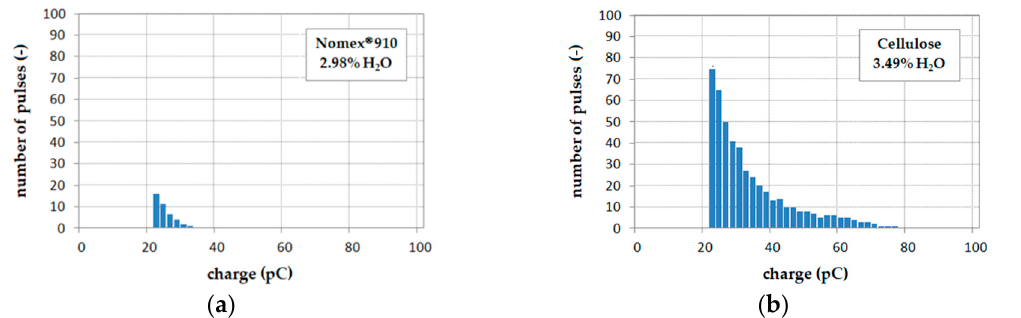
Figure 7. Frequency-amplitude distribution of partial discharges in aramid-enhanced cellulose paper ( a ) and cellulose paper ( b ), conditioned in the same conditions (medium moisture in paper); U = 9.3 kV.